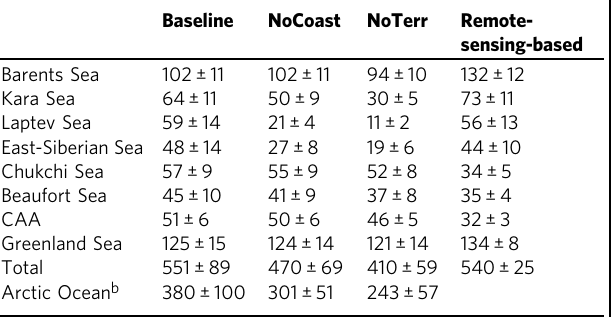
Table 2 Simulated and remote-sensing-based annual net primary production over 2005 – 2010 a north of the Arctic Circle at 66°N [Tg C yr − 1 ] and per region as de fi ned in the remote-sensing-based estimate 6 .